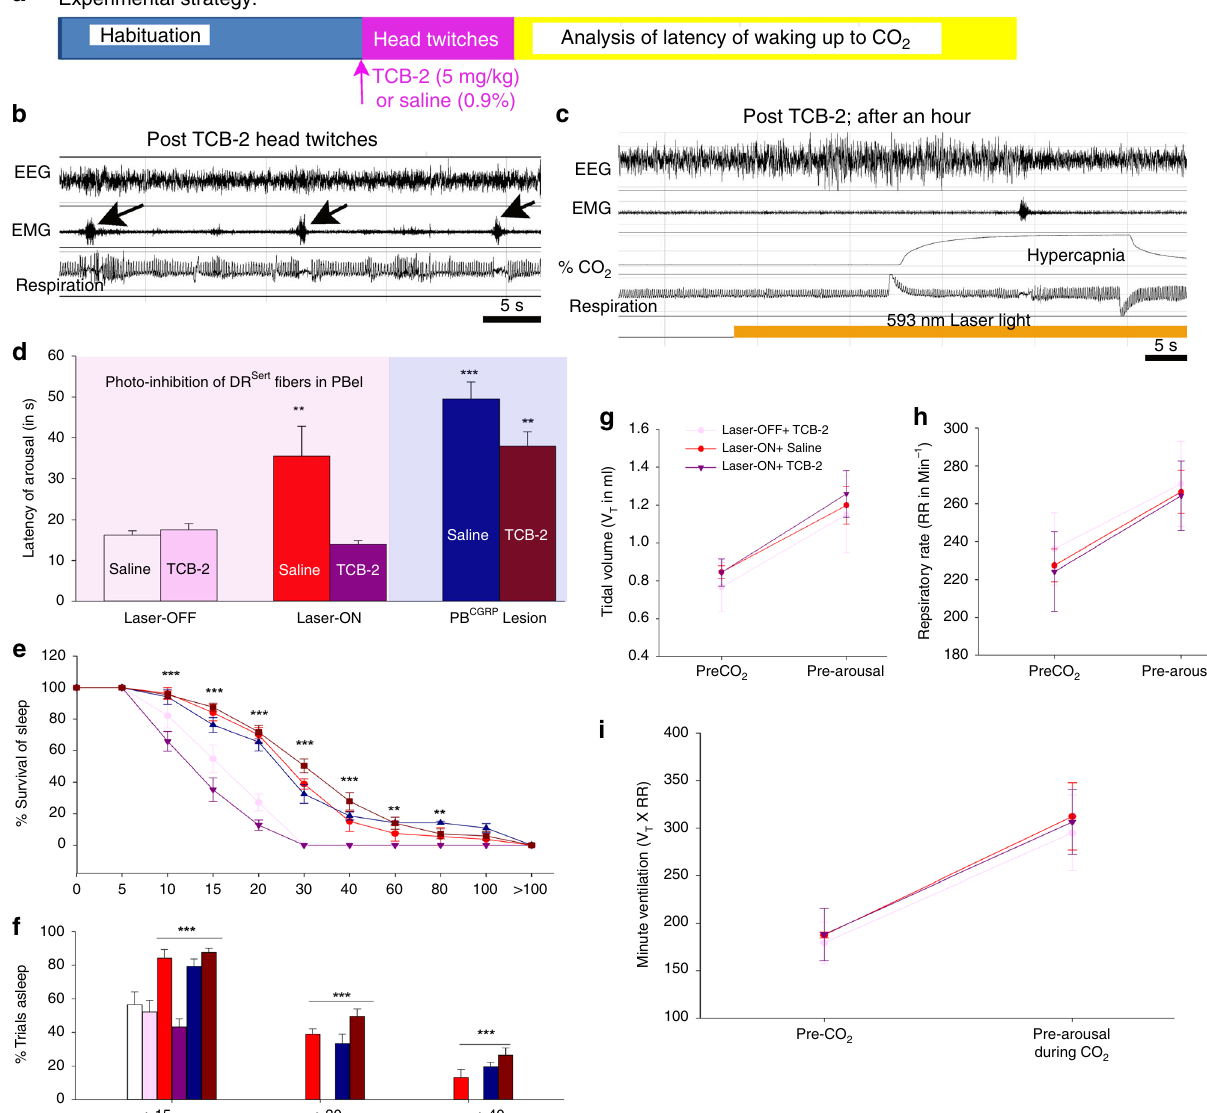
Fig. 8 5HT 2a agonist reverses blockade of CO 2 arousal caused by photoinhibition of DR Sert terminals in the PBel, but not by deletion of PBel CGRP neurons. Panel a shows the experimental strategy that involved 3 h habituation to the plethysmographic chamber followed by with intraperitoneal injections of either 0.9% saline or TCB-2 (5HT 2a agonist; 5 mg/Kg), and CO 2 exposure either with photoinhibition of the DR Sert terminals in the PBel or with deletions of the PBel CGRP neurons. b is a representative polysomnographic record showing head twitches in the fi rst hour after injection of TCB-2 (marked by arrows). To avoid confusion with arousal, this period was not used to analyze the latency of arousal to CO 2 . c shows a representative trial of CO 2 exposure more than one hour after TCB-2 injection when animals attained stable sleep; data in this 3 h period were used for analyzing the latency to waking up to CO 2 . Graphs d – f show for each group the mean (± SEM) latency of arousal ( d ), survival curves ( e ), and percent of trials (mean ± SEM) in which the animal remained asleep at various time points after onset of CO 2 exposure ( f ). ** P < 0.01; *** P < 0.001; one-way ( d ) or two-way ANOVA ( e and f ). Silencing the DR Sert terminals in PBel (Laser-ON) is compared here with the control (Laser-OFF), in both conditions (with injection of the 5HT 2a agonist- TCB-2 or saline; n = 3). Activation of 5HT 2a receptors completely reversed the blockade of hypercapnia-induced arousal caused by inhibiting DR Sert terminals in the PBel (F 3,9 = 8.05; P = 0.006 for Laser-ON-saline, P = 0.91 for Laser-ON TCB-2, one-way ANOVA followed by multiple comparisons of treatment groups). In the PBel CGRP deletion mice ( n = 5), the arousal to CO 2 is compared between the saline and TCB-2 groups (F 5,17 = 15.4; P < 0.001 for saline and P = 0.002 for TCB-2, one-way ANOVA followed by multiple comparisons), where TCB-2 is ineffective in restoring the hyperapnia-induced arousal in the absence of the PBel CGRP neurons. Effect of TCB-2 (5HT 2a receptor agonist) on respiration: g – i The respiratory air fl ow signals prior to CO 2 exposure and during CO 2 but prior to EEG arousal were analyzed off-line for tidal volume (mean ± SEM) ( g ), respiratory rate (mean ± SEM) ( h ), and minute ventilation ( i ). Laser-ON with either TCB-2 or saline injection, or Laser-OFF with TCB-2, showed identical tidal volume, respiratory rate, and minute ventilation prior to and during CO 2 exposure, indicating that neither inhibition of the DR Sert terminals in the PBel nor restoring the CO 2 arousal response with TCB-2 affects the ventilatory response to CO 2 . Data in d – i are presented as mean values ±